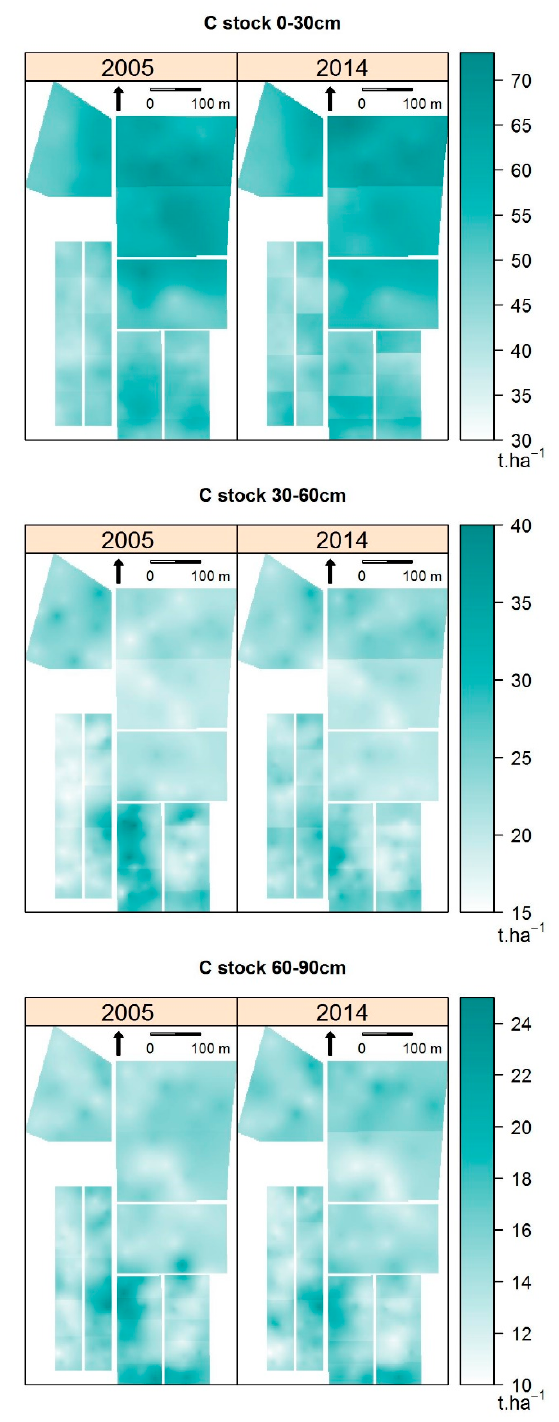
Figure 2. Co-kriging predicted C 2005 stock and C 2014 stock for 0–30, 30–60 and 60–90 cm depths.